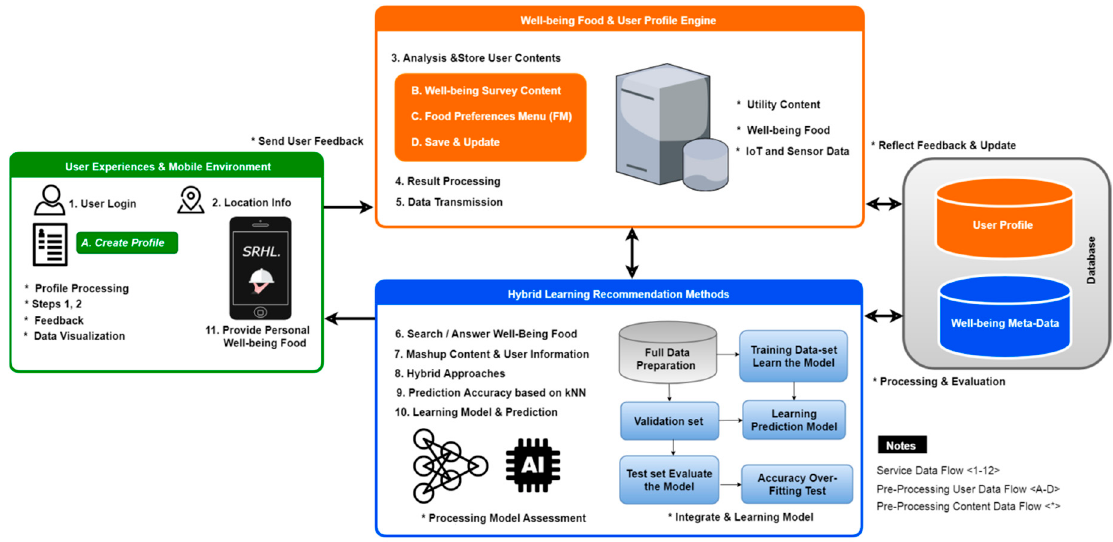
Figure 2. Service model.